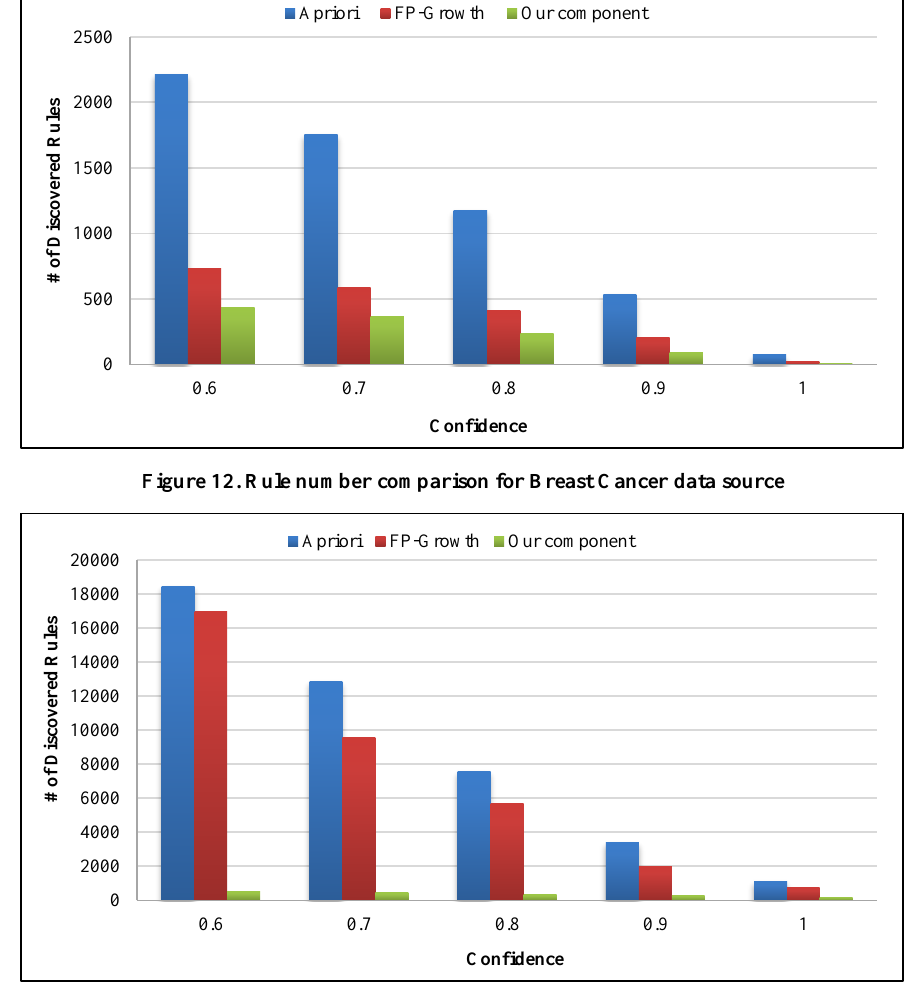
Figure 13. Rule number comparison for Restaurant data source